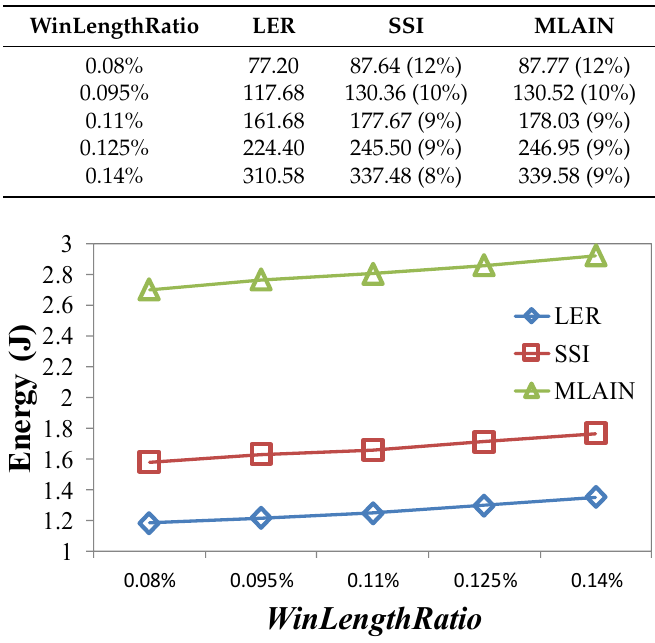
Figure 10. Average energy consumption for changing WinLengthRatio values.